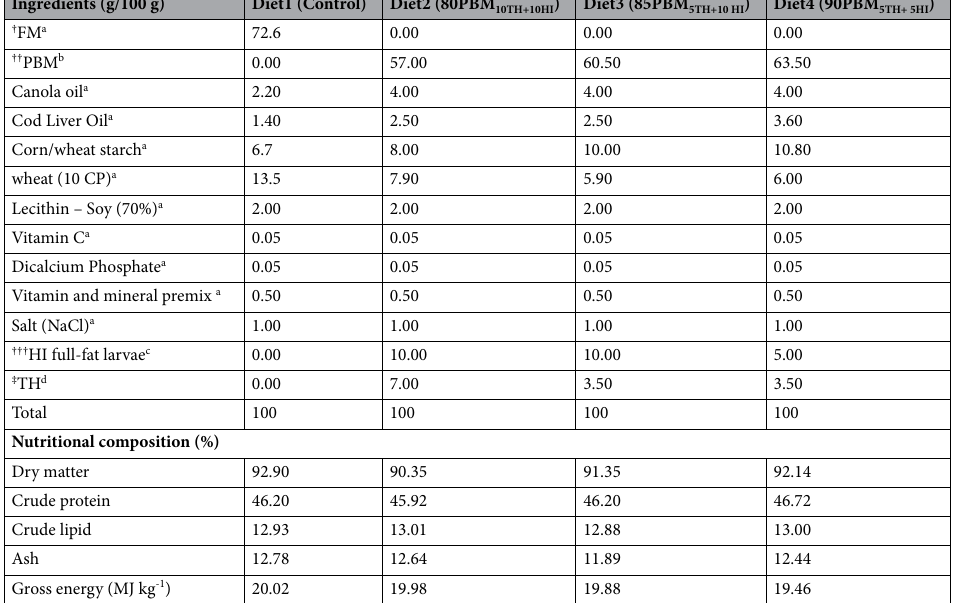
Table 1. Ingredients and nutritional composition of four experimental diets (% dry matter basis). a Purchased from Specialty Feeds, Glen Forrest Stockfeeders, 3150 Great Eastern Highway, Glen Forrest, Western Australia 6071. † Fishmeal (FM): 64.0% crude protein, 10.76% crude lipid and 19.12% ash. †† Poultry by-product meal (PBM): 67.13% crude protein, 13.52% crude lipid and 13.34% ash. ††† † HI ( Hermetia illucens ) larvae: 40.04% crude protein, 28.30% crude lipid, 7.81% moisture and 8.91% ash. ‡ Tuna hydrolysate (TH): 37.91% crude protein, 5.50% crude lipid, and 11.05%